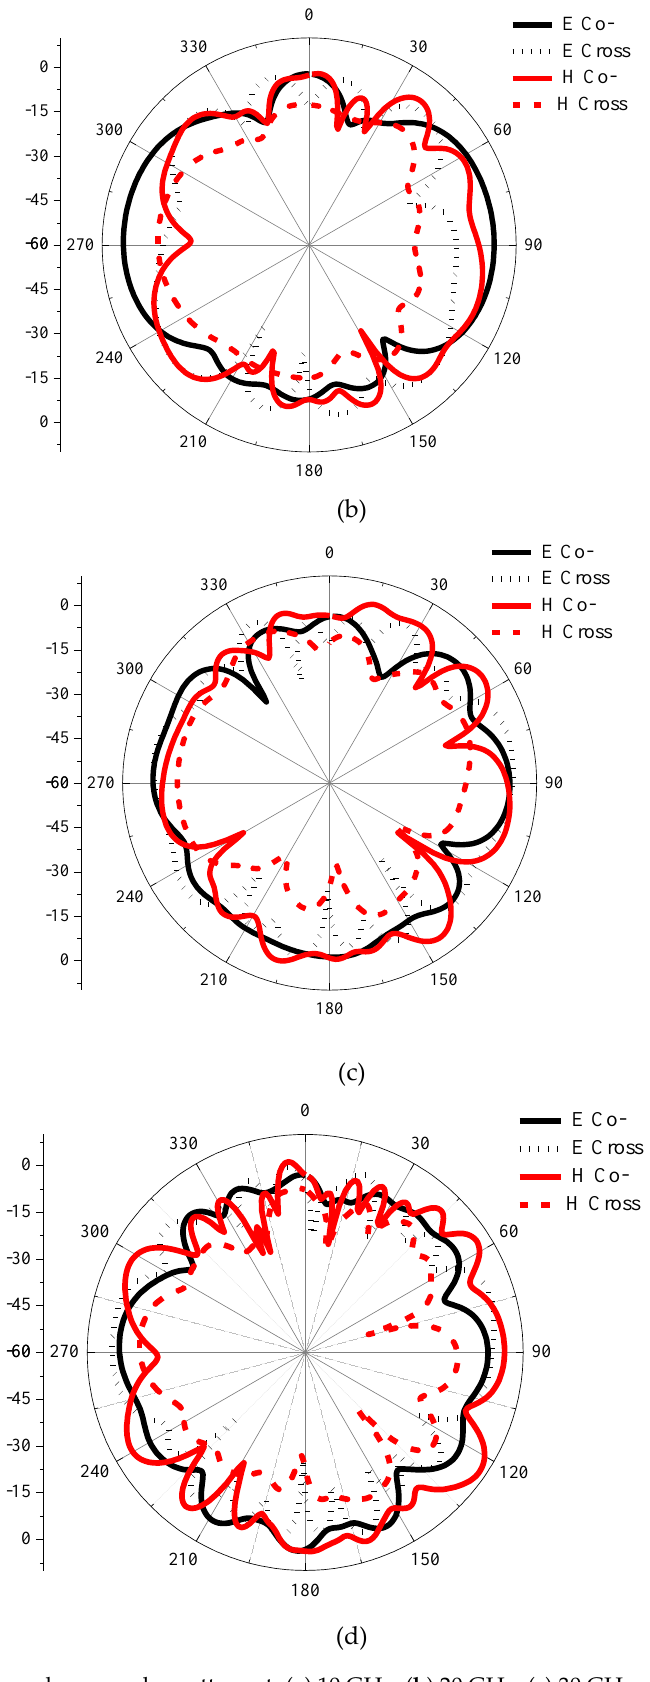
Figure 13. The co- and cross-polar pattern at: ( a ) 10 GHz; ( b ) 20 GHz; ( c ) 30 GHz; and ( d ) 40 GHz in both E- and H-plane.